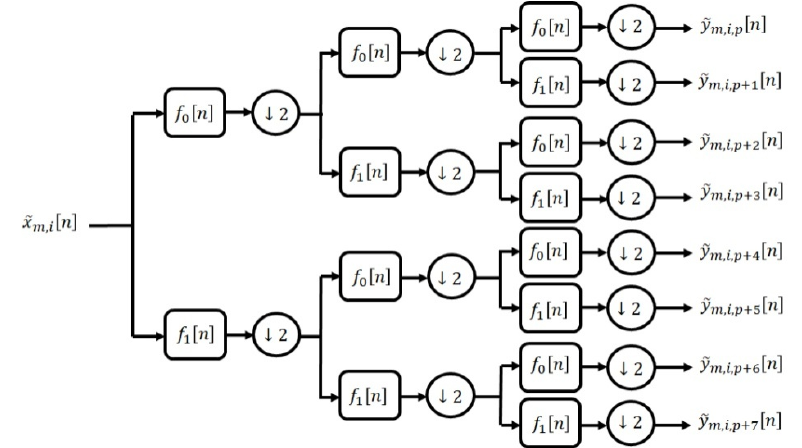
Figure 7. The 3-levels and 2-channels structure for filter bank in adaptive wavelet packet decomposition (AWPD).